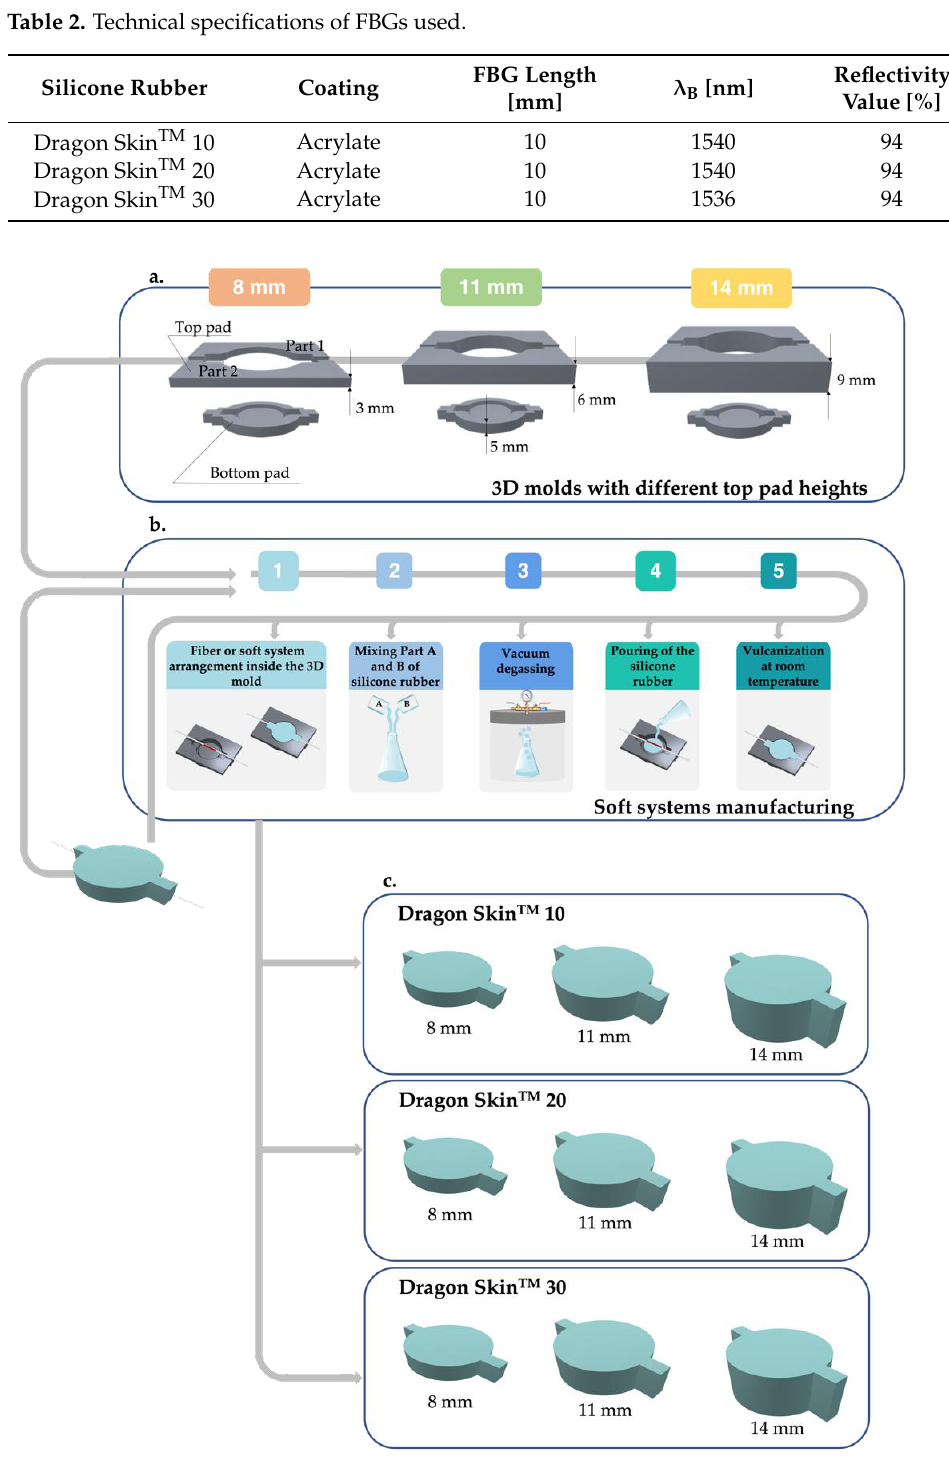
Figure 2. ( a ) Representation of 3D molds consisting of a bottom pad and top pad with different heights (i.e., 3 mm, 6 mm, and 9 mm) to gain the desired thicknesses (8 mm, 11 mm, and 14 mm). ( b ) Manufacturing steps: (1) fiber or soft systems arrangement inside the 3D mold; (2) mixing Part A and Part B of silicone rubber; (3) vacuum degassing; (4) pouring of the silicone rubber; (5) vulcanization at room temperature. ( c ) Extraction of 8 mm, 11 mm, and 14 mm SSs for Dragon Skin TM 10, 20, and 30.